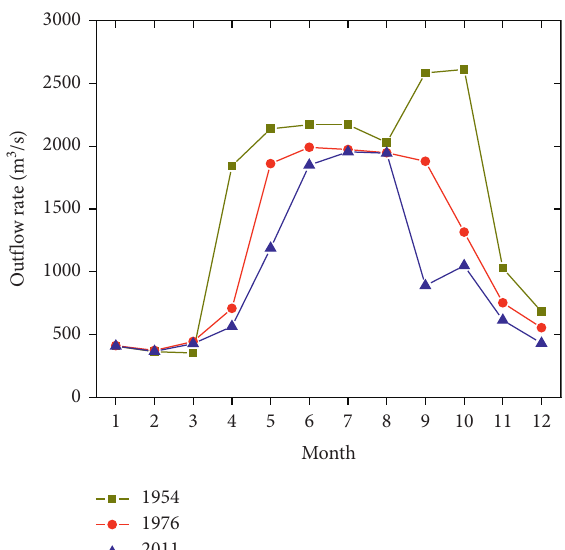
Figure 7: Outflow rate results of the three typical years.